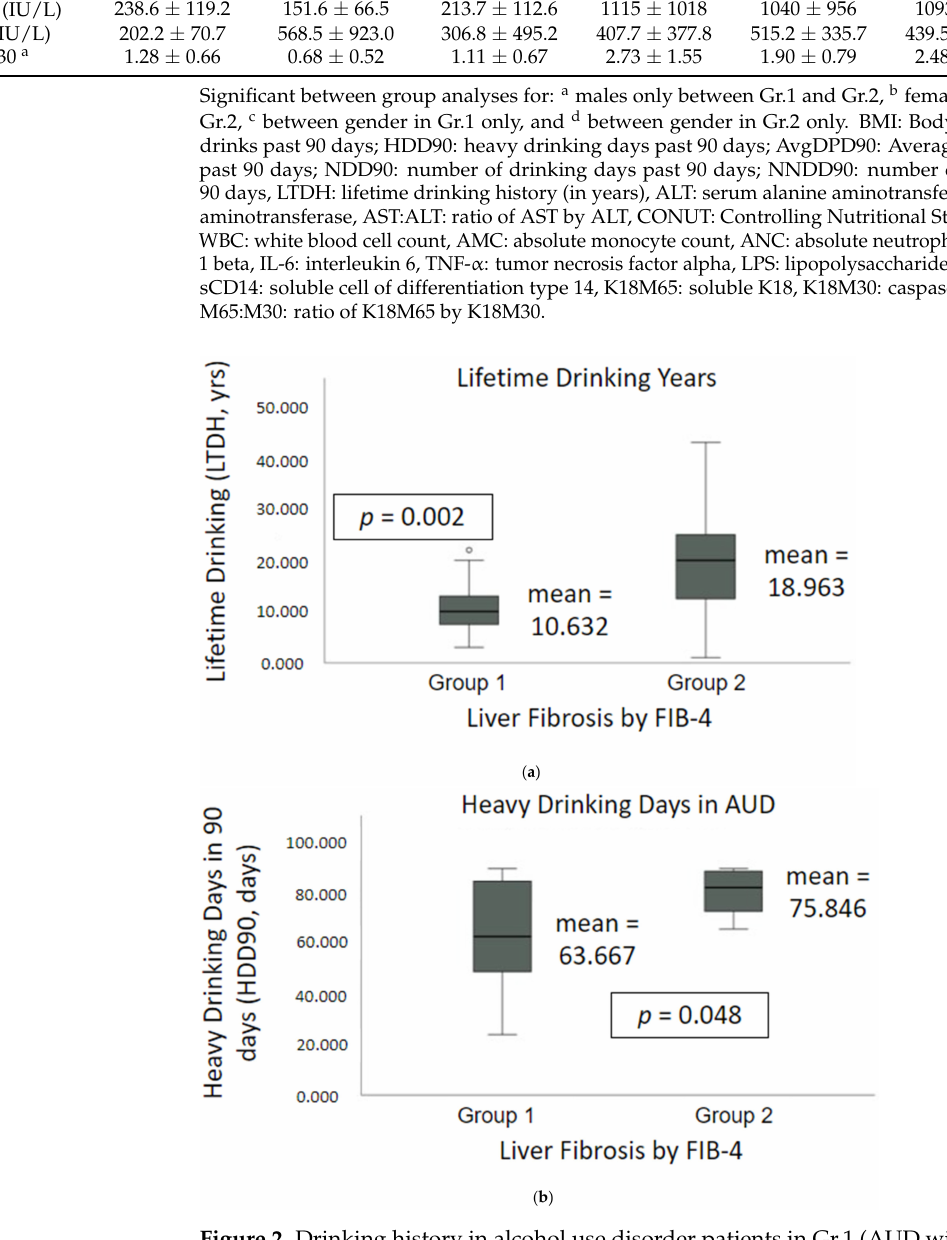
Figure 2. Drinking history in alcohol use disorder patients in Gr.1 (AUD without fibrosis) and Gr.2 (AUD with fibrosis). ( a ) Lifetime drinking years (LTDH) in Gr.1 vs. Gr.2; ( b ) Number of heavy drinking days in the past 90 days in Gr.1 vs. Gr.2. ◦ outlier values. Among patients with baseline elevated FIB-4, patients in Gr.2d (FIB-4 > 3.25) demon- strated no significant differences in age or BMI when compared to Gr.2c (1.45 ≤ FIB-4 ≤ 3.25) (Table 2). Gr.2d did have a significantly higher HDD90 and a significantly lower LTDH (Table 2). There were also no significant differences in